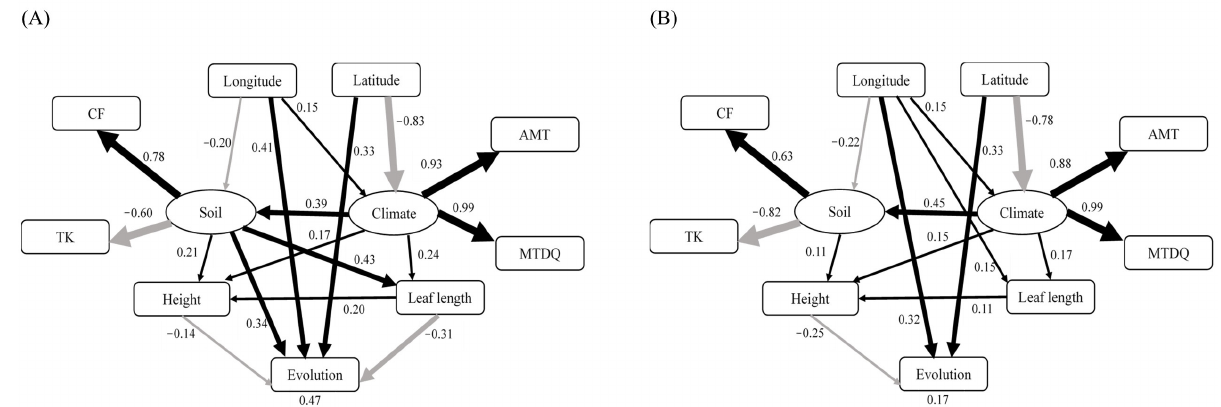
Figure 5. The effect of structural equation models (SEM) of environmental factors on trait variations during evolution of non-endemic bamboos ( A ) ( X 2 = 28.401; df = 17, p = 0.056; RMSEA = 0.068; AIC = 84.859 in SEM-A) and endemic bamboos ( B ) ( X 2 = 13.636; df = 17, p = 0.050; RMSEA = 0.043; AIC = 84.401 in SEM-B) in Chinese bamboos. Note: Black and gray arrows indicate significant positive and negative relationships ( p < 0.05), respectively. Arrow width denotes the strength of the causal influence and the numbers are standardized path coefficients. The percentage of explanation of the models on the chosen factors is represented by R 2 . CF, Clay fraction; TK, Total potassium; AMT, Annual mean temperature; MTDQ, Mean temperature of driest quarter.